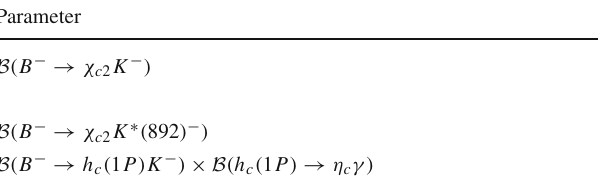
Table 162 Decays to charmonium other than J /ψ and one kaon II [ 10 − 5 ] Parameter Measurements